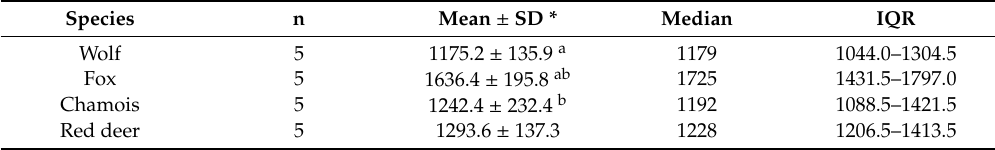
Table 2. Total numbers of inflammatory cells in skin mange lesions from four species.